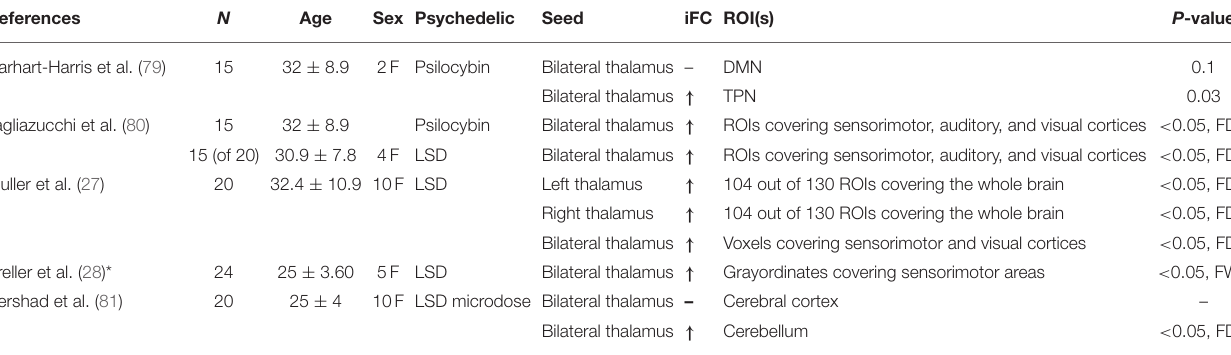
TABLE 1 | Thalamocortical connectivity after administration of